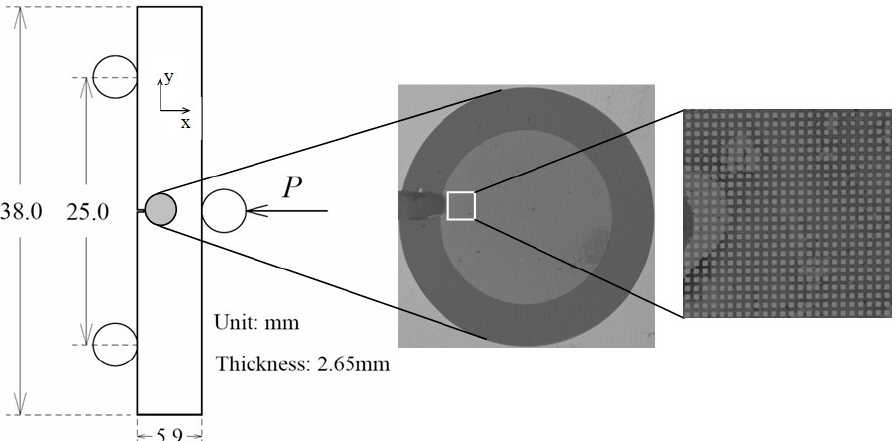
Figure 1. Geometry of the three-point bending specimen for the in situ SEM test and microscale grating pattern around its notch.